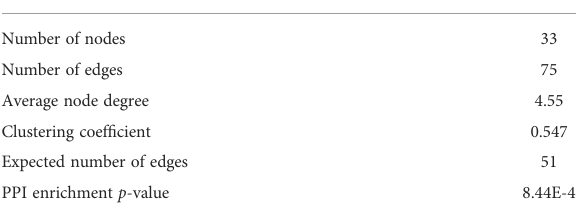
TABLE 4 Summary of immune-related PPI